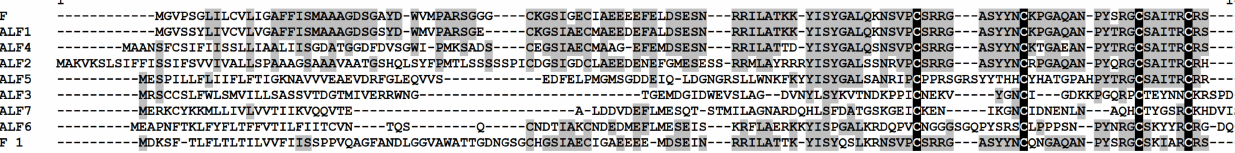
Figure 11. Multiple sequence alignment of S. lycopersicum RALF precursors and RALF from Nicotiana tomentosiformis (XP_00962090.1), RALF 1 from A. thaliana (NP_171789.1). Cysteine residues are shaded black, and identical amino acids are shaded